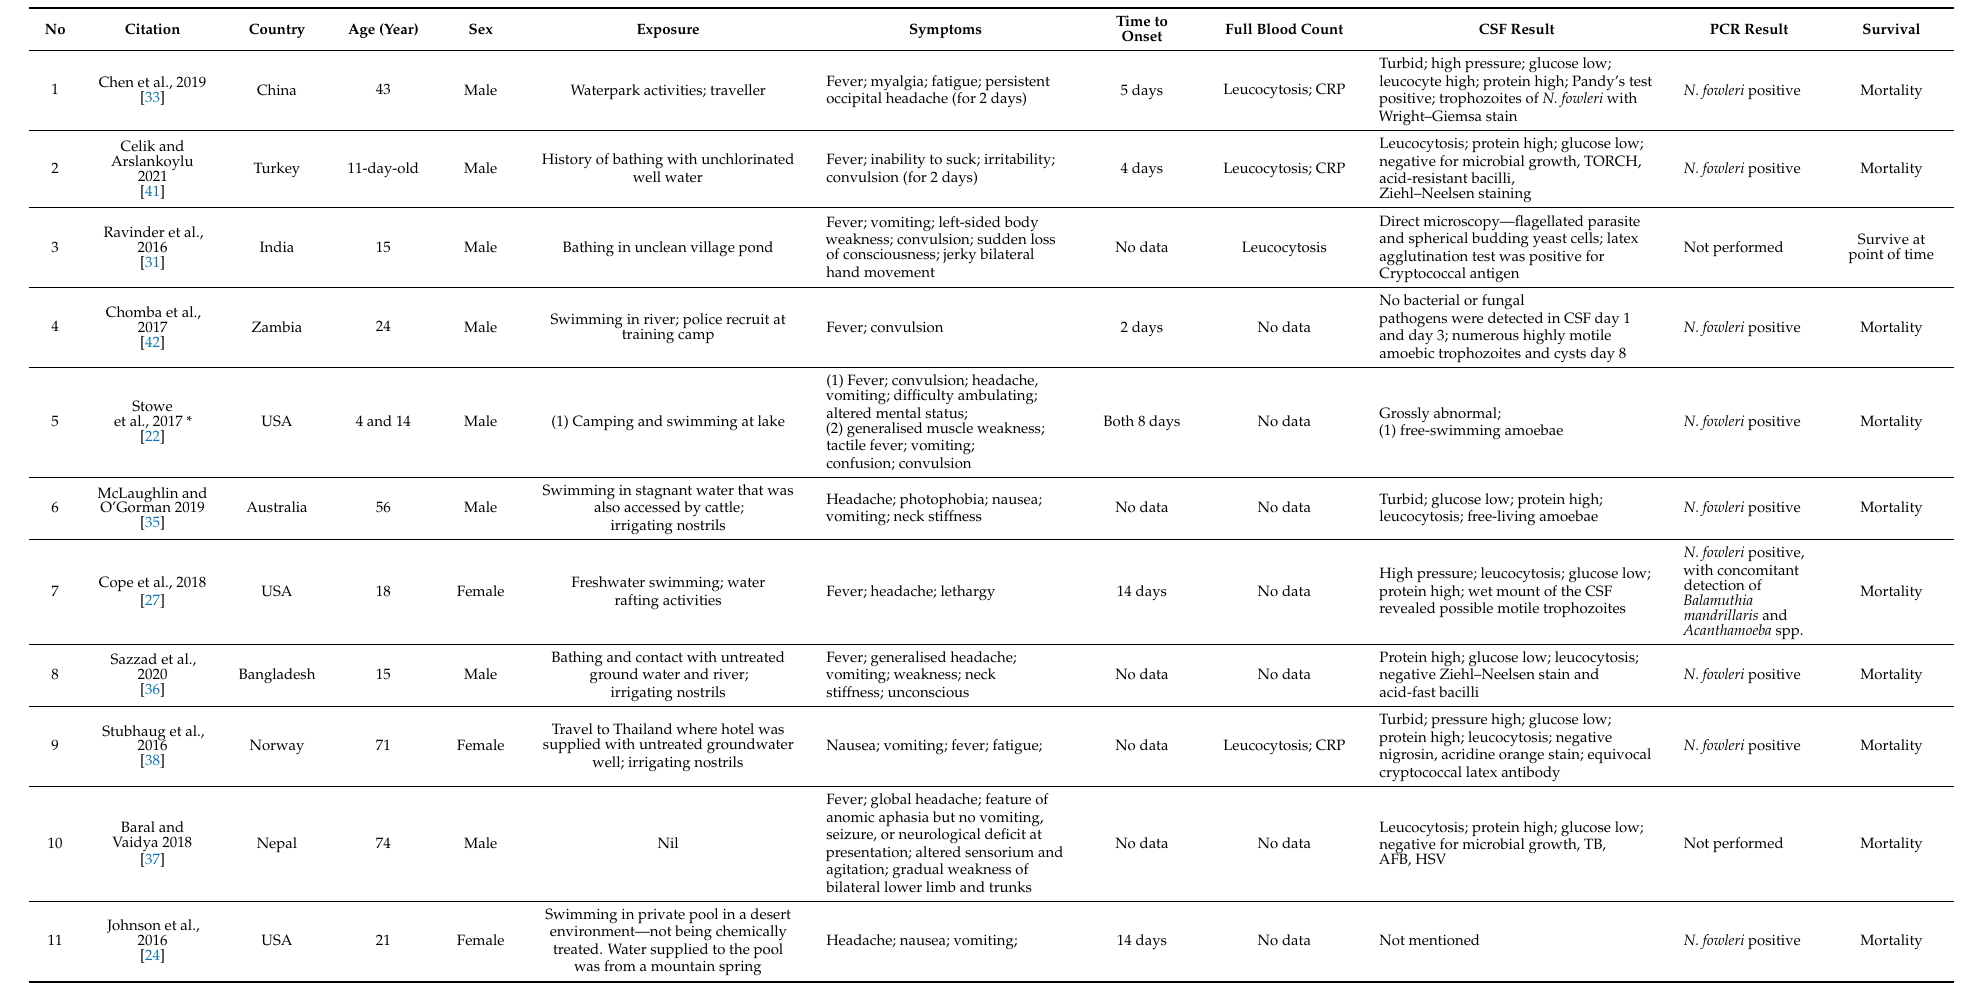
Table 1. Epidemiological, clinical, and laboratory data of the PAM cases